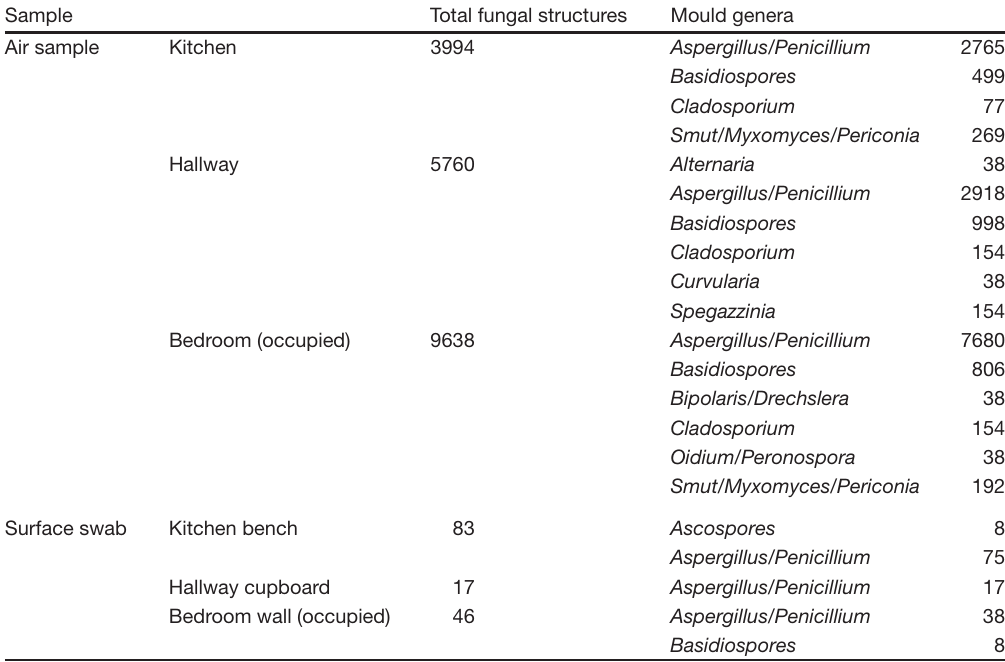
Table 3. Results of the mould sampling (expressed in FS/m 3